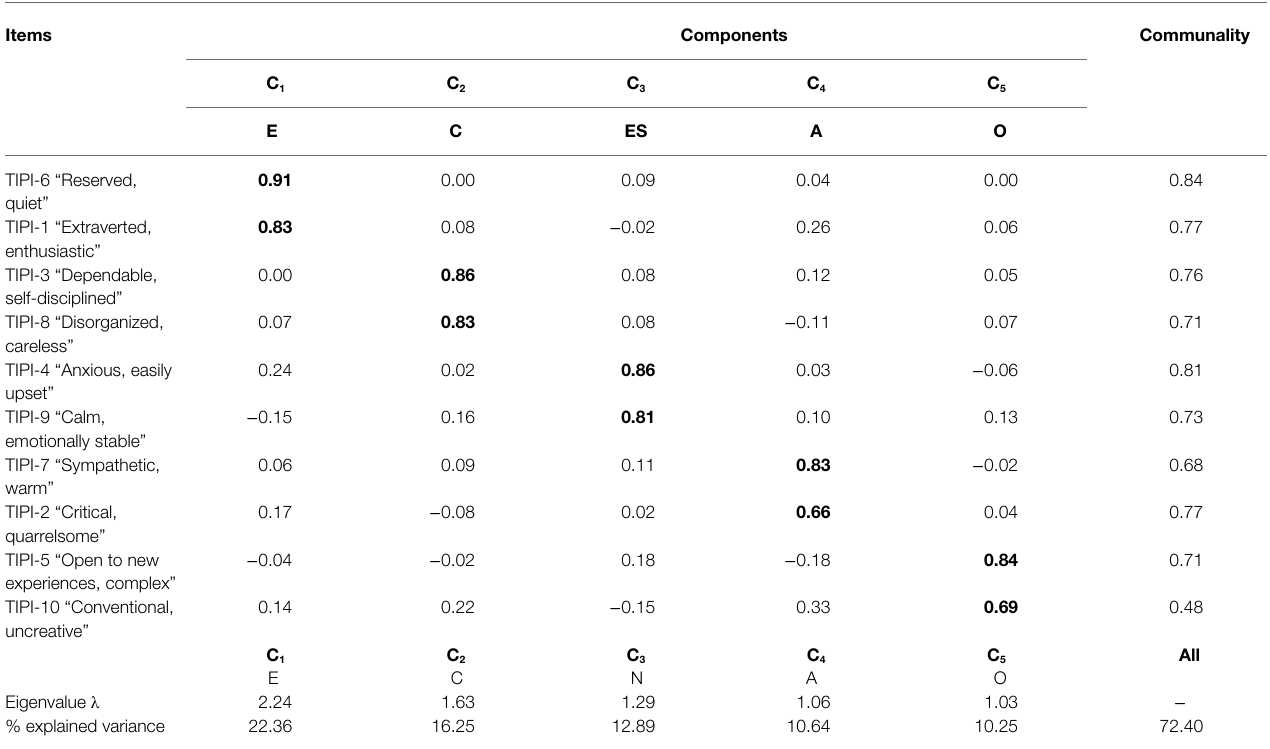
TABLE 7 | Component structure for the 10 N-TIPI items. Items